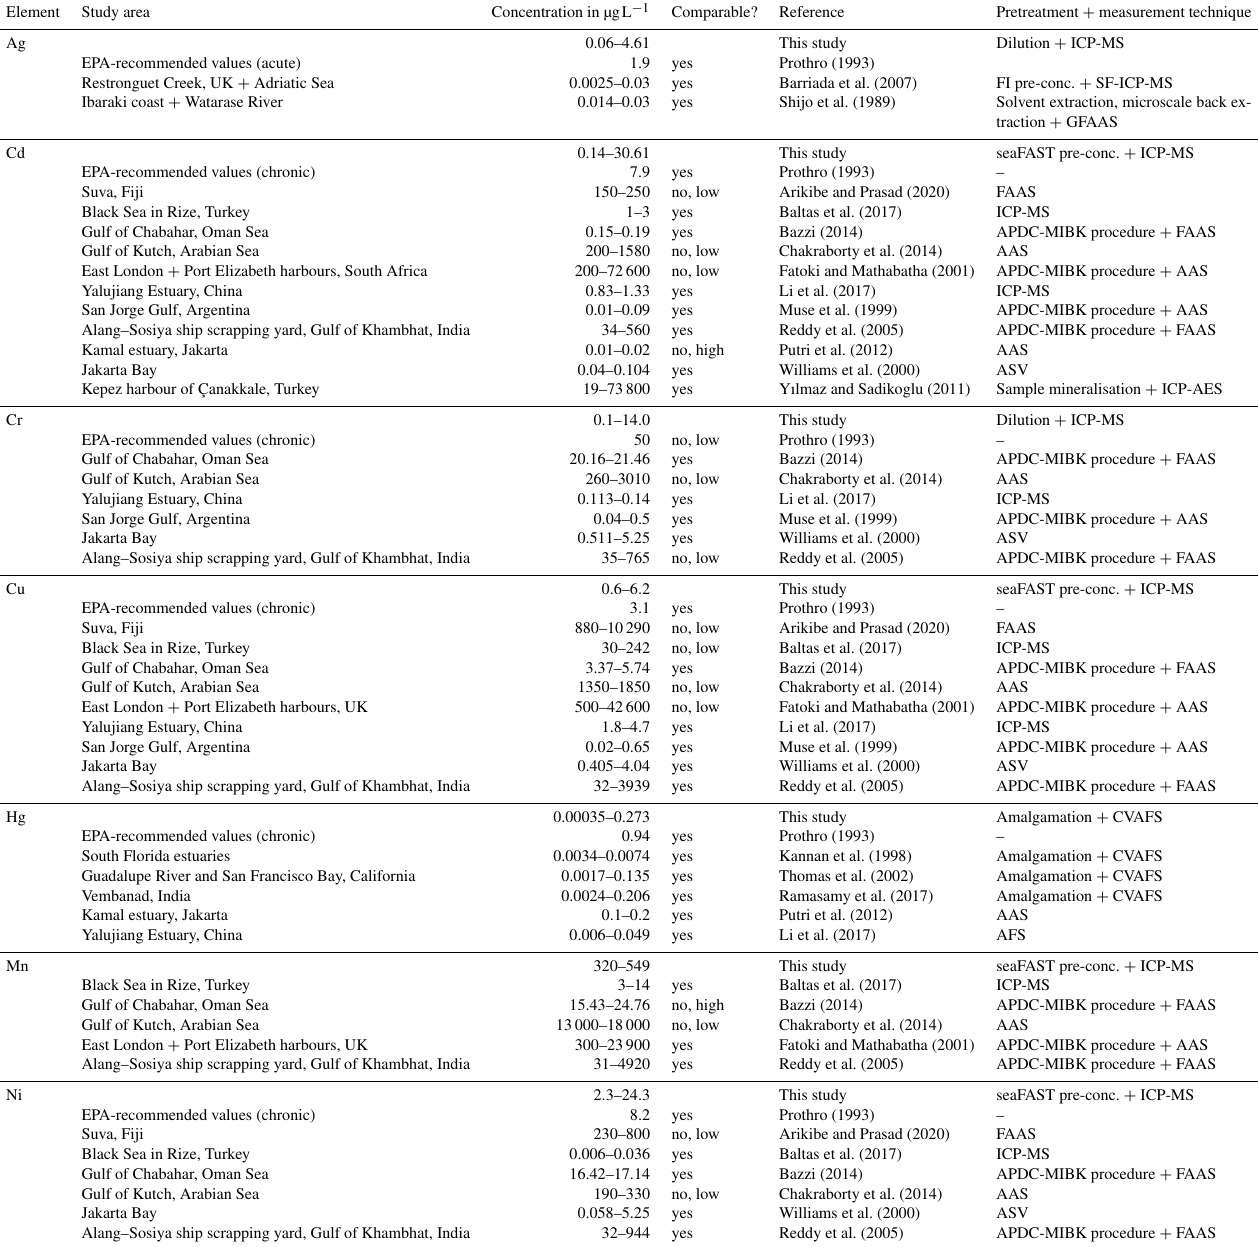
Table A4. Comparison of the heavy metal concentrations in seawater of different regions of the world to values used for the culturing ex- periments in this study. It is indicated whether the values of this study are comparable to environmental values or whether values from this study are higher or lower. EPA denotes Environmental Protection Agency, USA; FI denotes field injection; SF-ICP-MS denotes sector field inductively coupled plasma mass spectrometry; GF denotes graphite atomic; (F)AAS denotes (flame) graphite atomic absorption spectrom- etry; APDC-MIBK denotes ammonium pyrrolidine dithiocarbamate-methyl isobutyl ketone; ASV denotes anodic stripping voltammetry; AES denotes atomic emission spectrometry; CVAFS denotes cold vapour atomic fluorescence spectrometry; FPD denotes flame photometric